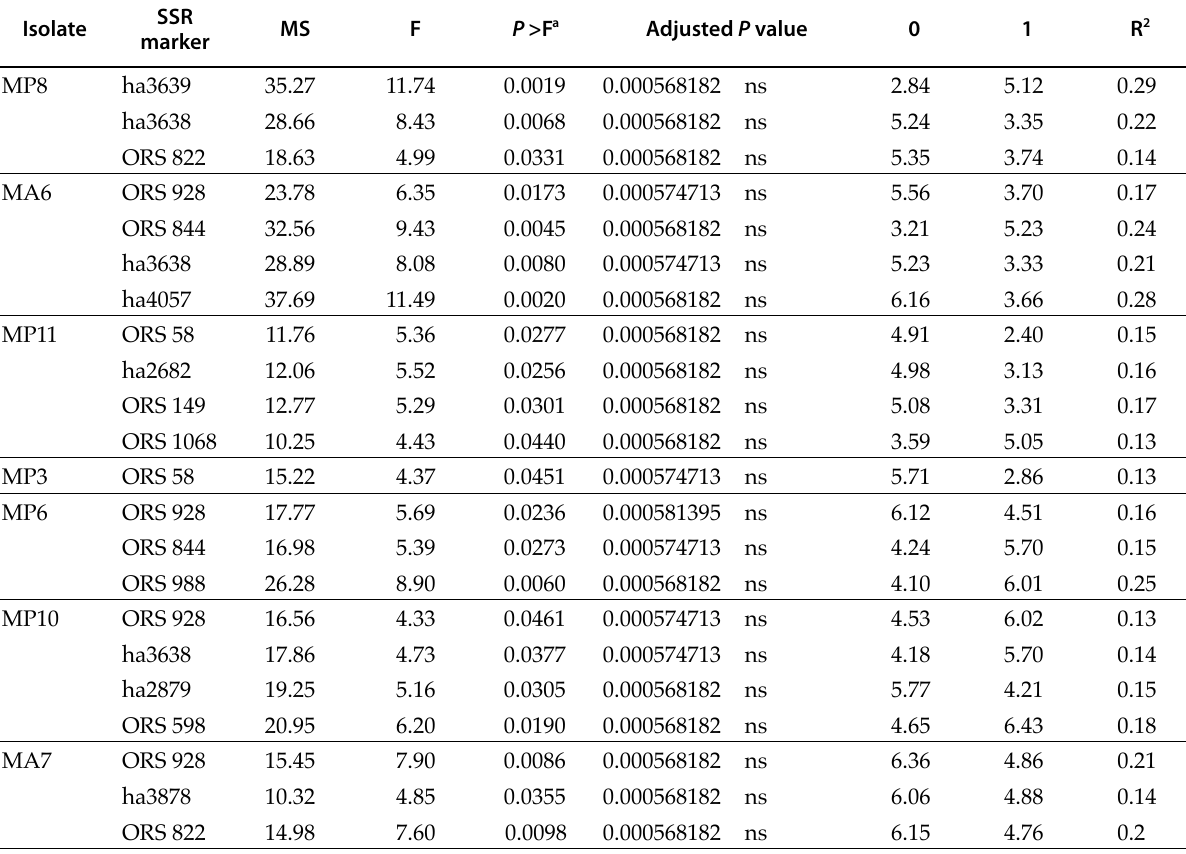
Table 3. SSR markers detected for partial resistant to Phoma macdonaldii isolates in sunflower using single-marker analysis. SSR MS F P >F Isolate marker